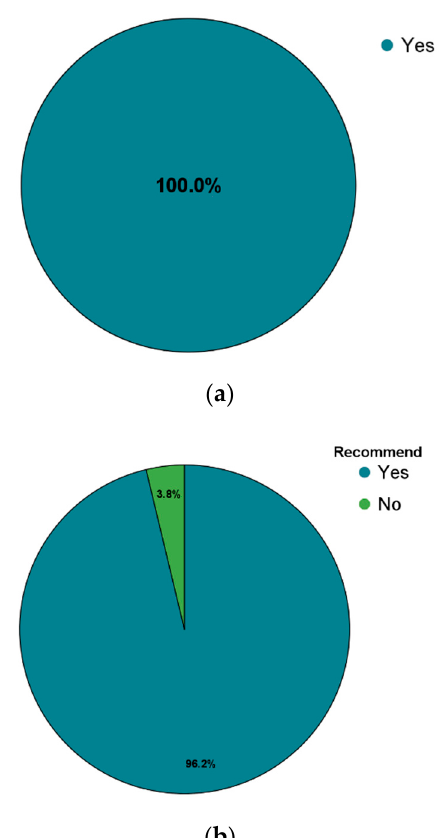
Figure 18. ( a ) Responses related to the willingness to make use of the Anat_Hub mobile application for study purposes; and ( b ) willingness to recommend the Anat_Hub mobile application to others.